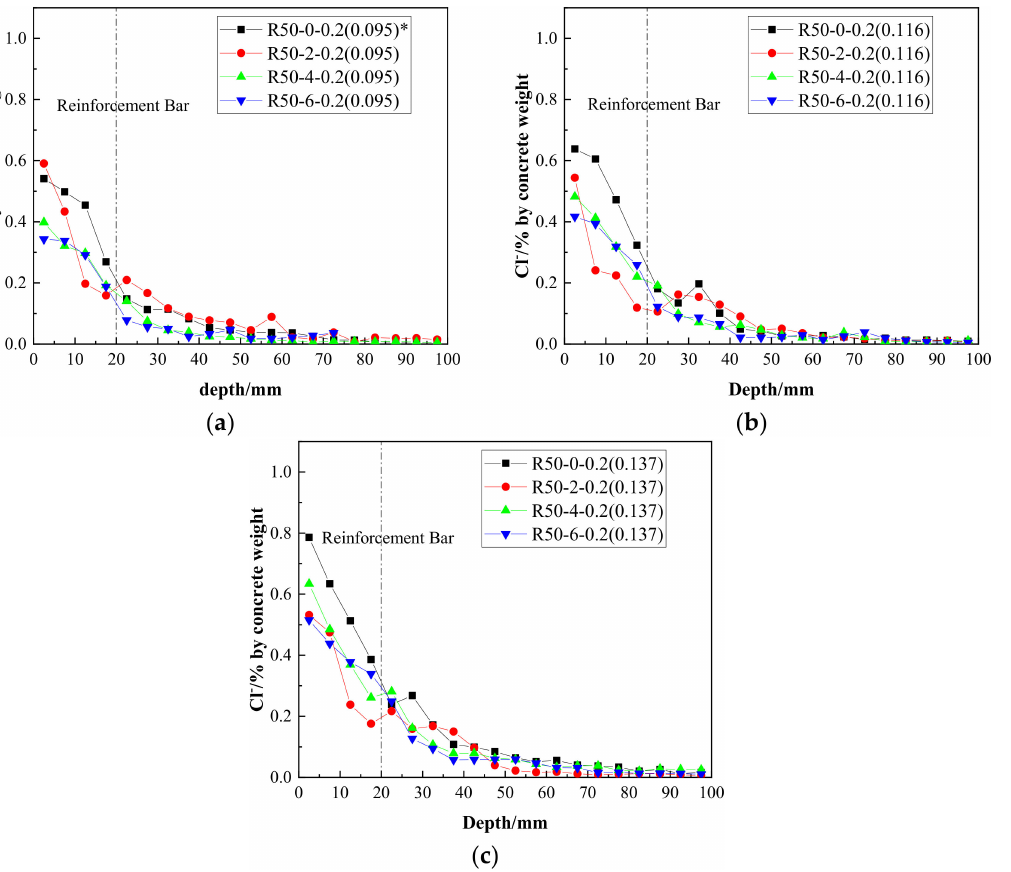
Figure 11. Distribution of chloride ion content at different depths as a function of nano-silica content when w = 0.095 mm ( a ), w = 0.116 mm ( b ) and w = 0.137 mm ( c ). Note (*): the values in brackets refer to the actual widths of the cracks selected in the specified